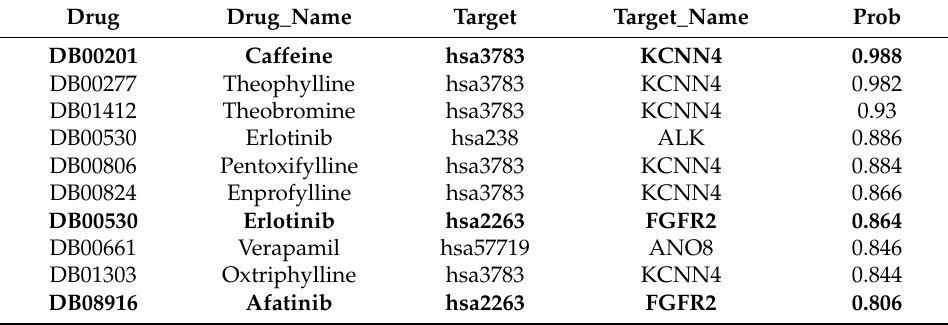
Table 3. Drug-target pairs ranked by prediction